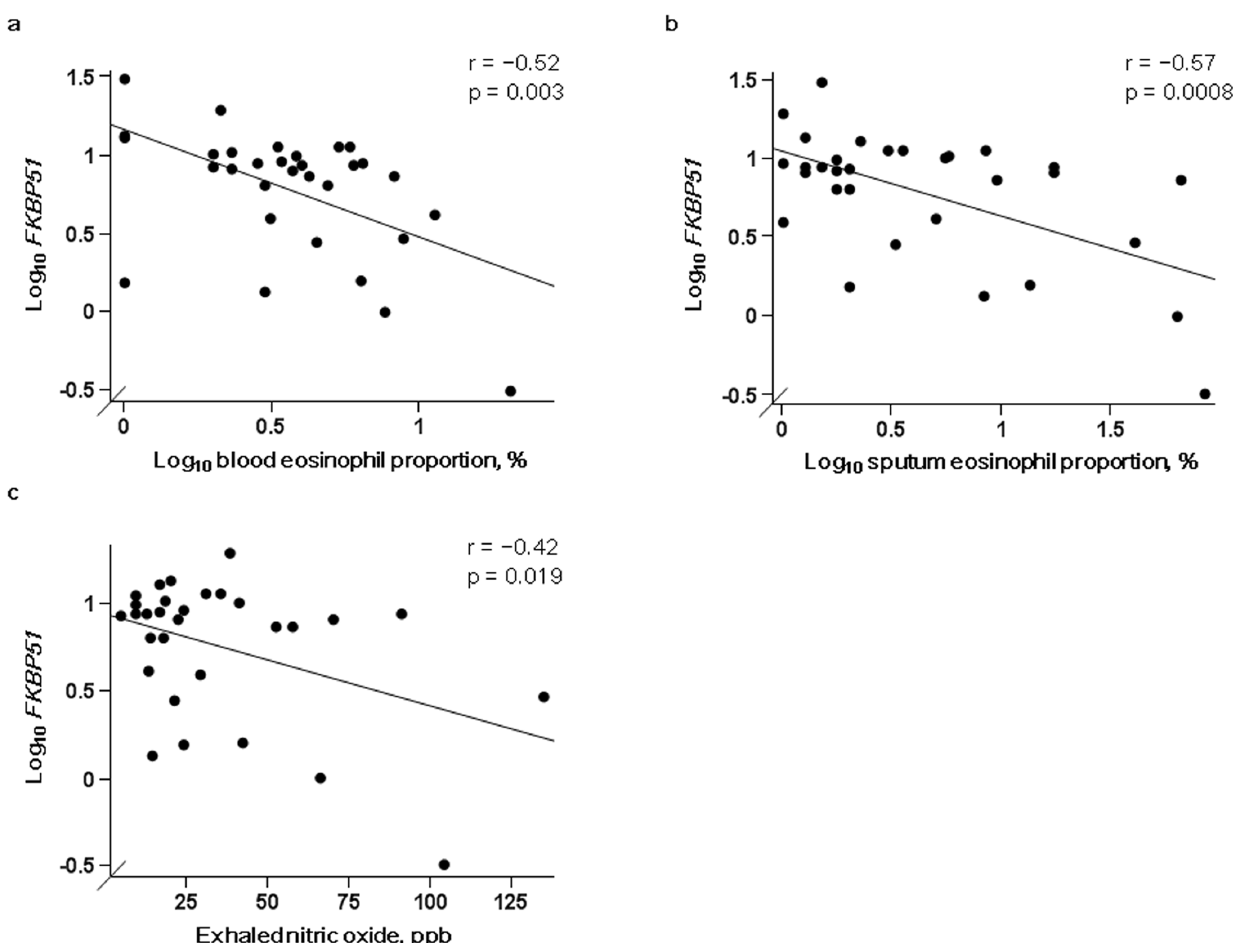
Figure 2. Associations between FKBP51 levels and eosinophilic inflammation in steroid-naı¨ve patients with asthma. Associations between FKBP51 mRNA levels normalized to b 2 microglobulin mRNA levels and a) blood and b) sputum eosinophil proportions (n=31 each) and c) exhaled nitric oxide levels (n=30) in steroid-naı¨ve patients with asthma.